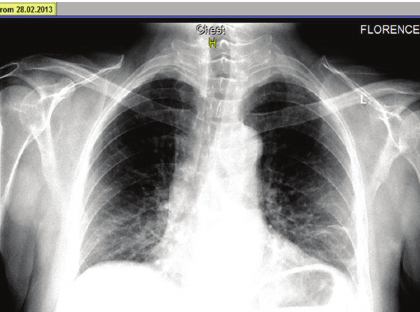
Figure 3: Axial view of thorax CT showing multiple, linear hyper- densities in bilateral lobar pulmonary artery branches.